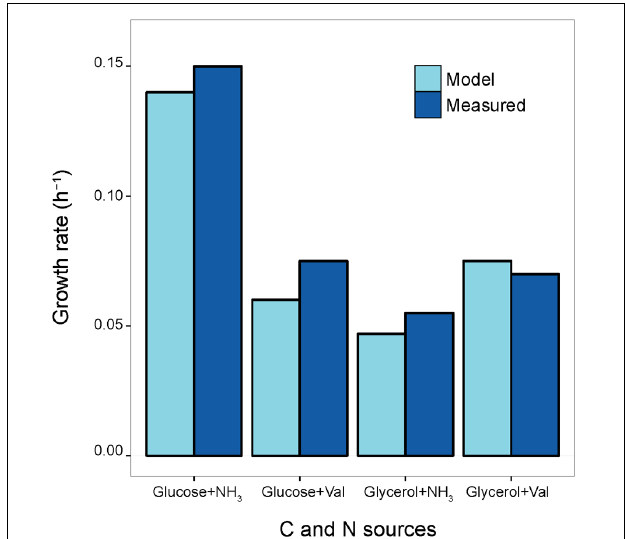
FIGURE 3 | Growth Rates. Comparison between model-predicted growth rates and experimentally determined ones on four minimum growth media providing different Carbon (C) and Nitrogen (N) sources (glucose and ammonium, glucose and valine, glycerol and ammonium, glycerol, and valine). The values reported by the blue bars correspond to measurements obtained from previously published works (Lounès et al., 1995, Lounès et al., 1996a,b; Colombie et al.,